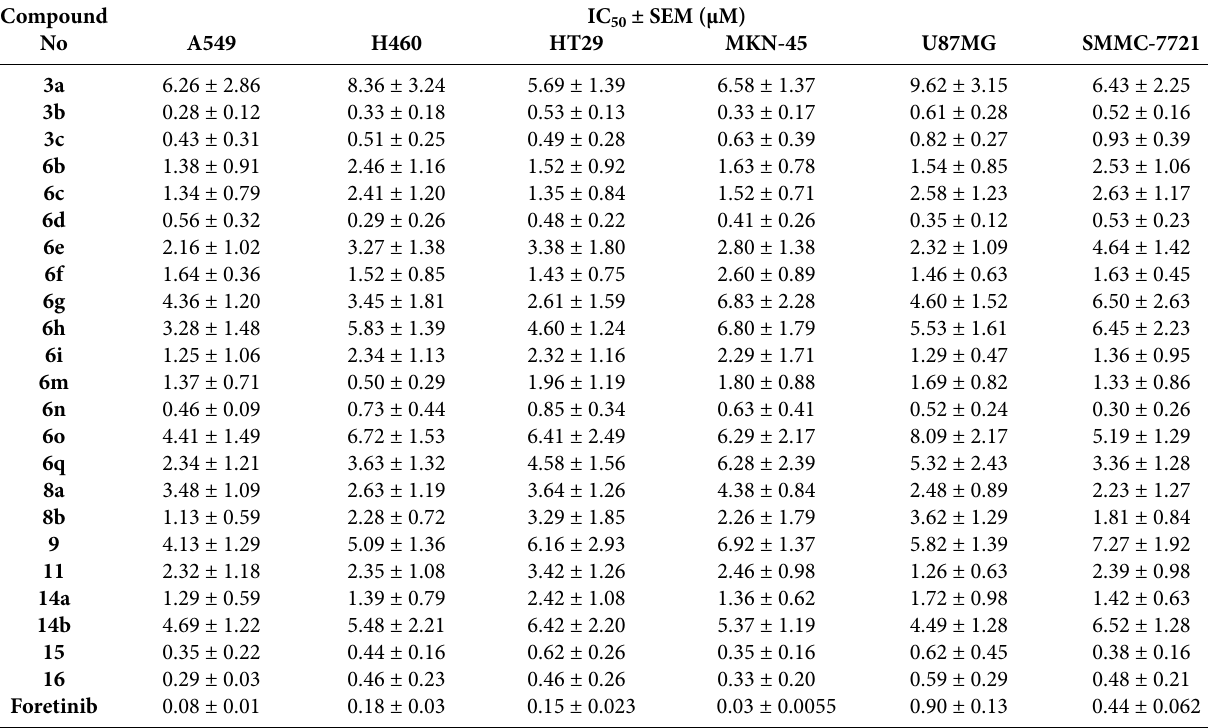
Table 1. In vitro growth inhibitory effects IC 50 ± SEM (µM) of selected compounds of the synthesized compounds against cancer cell lines Compound